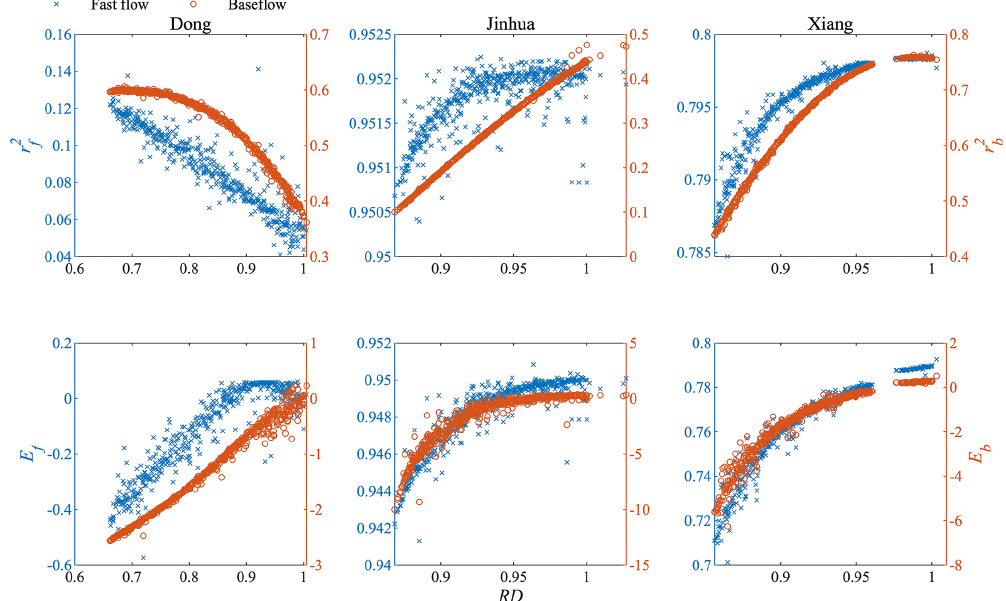
Figure 13. Correlation coefficients and Nash–Sutcliffe efficiency coefficients for fast flow and baseflow, respectively, in last-generation models for the three cases.